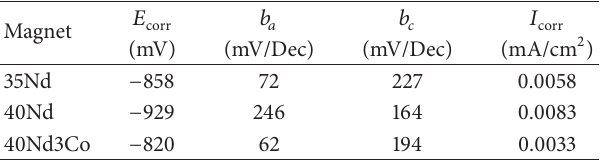
Table 2: Electrochemical parameters of the Nd magnets tested in 3.5% NaCl solution at 25 ∘ C for 24 hours.